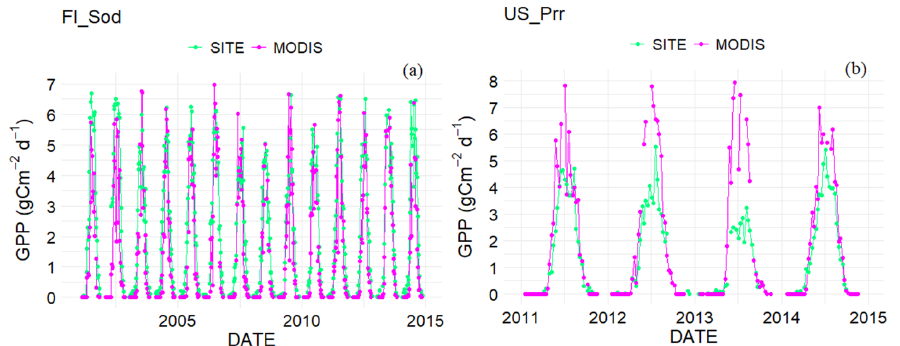
Figure 4. Time series comparison between site-based GPP and MOD17A2H over forest sites, ( a ) and ( b ) refers to FI_Sod and US_Prr.